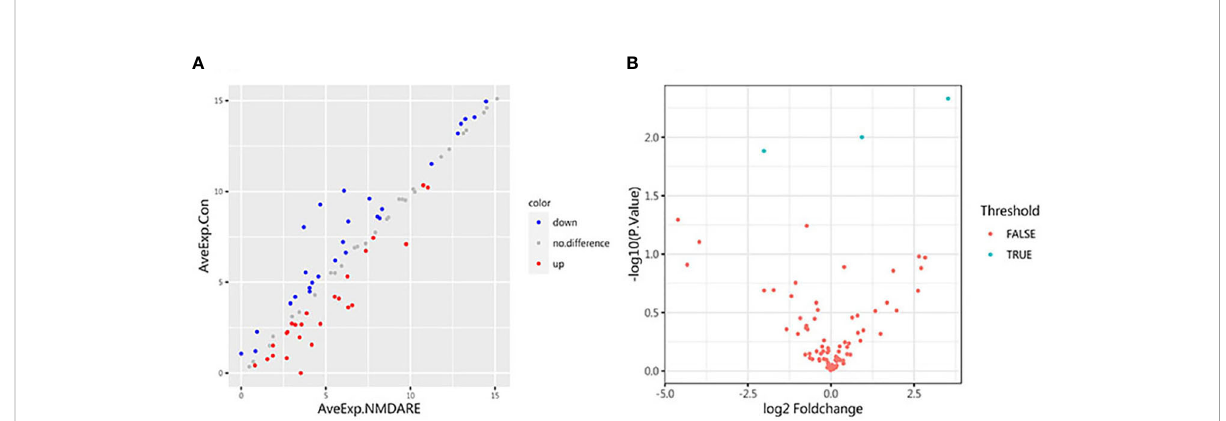
FIGURE 1 Scatter plot and volcano plot. (A) The abscissa and ordinate are the average expression of CSF cytokines in the anti-NMDAR encephalitis group and the control group, respectively. Red dots represent upregulated proteins. Blue dots represent downregulated proteins. (B) Volcano plot for identi fi ed proteins in CSF between anti-NMDAR encephalitis patients and control group patients. The differences in 80 cytokines between the anti-NMDAR encephalitis patients and the control group are shown according to fold change ( x -axis, Log2 fold change) and p -value ( y -axis, − log10 p -value). Blue dots represent cytokines or in fl ammatory mediators with p -value < 0.05 and fold change > 1.2 or < 0.83, from left to right: LAMP-1, MCSF, and cIAP-1; red dots denote cytokines or in fl ammatory mediators with p -value > 0.05, or 0.83 < fold change <